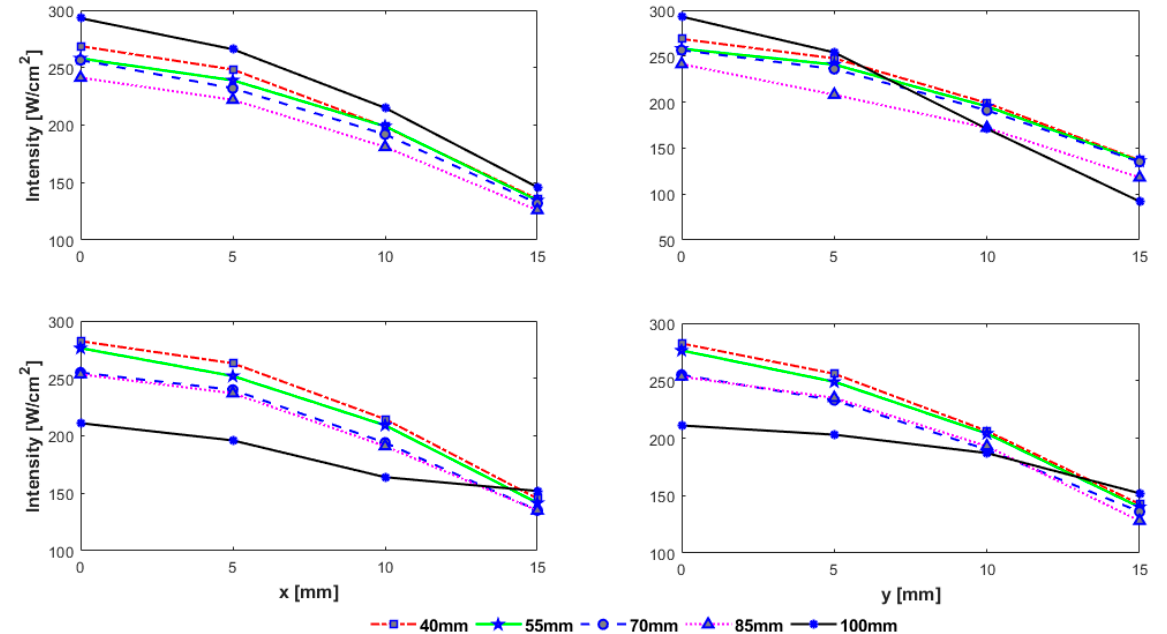
Figure 9. Change in the peak focal intensity with transverse steering for rib cage positioned at 40 mm, 55 mm, 70 mm, 85 mm, 100 mm at a nominal acoustic power of 15 W and when the array axis crosses center of the rib ( top row ), center of intercostal space ( bottom row ); steered in the x-direction ( left ), y-direction ( right ).